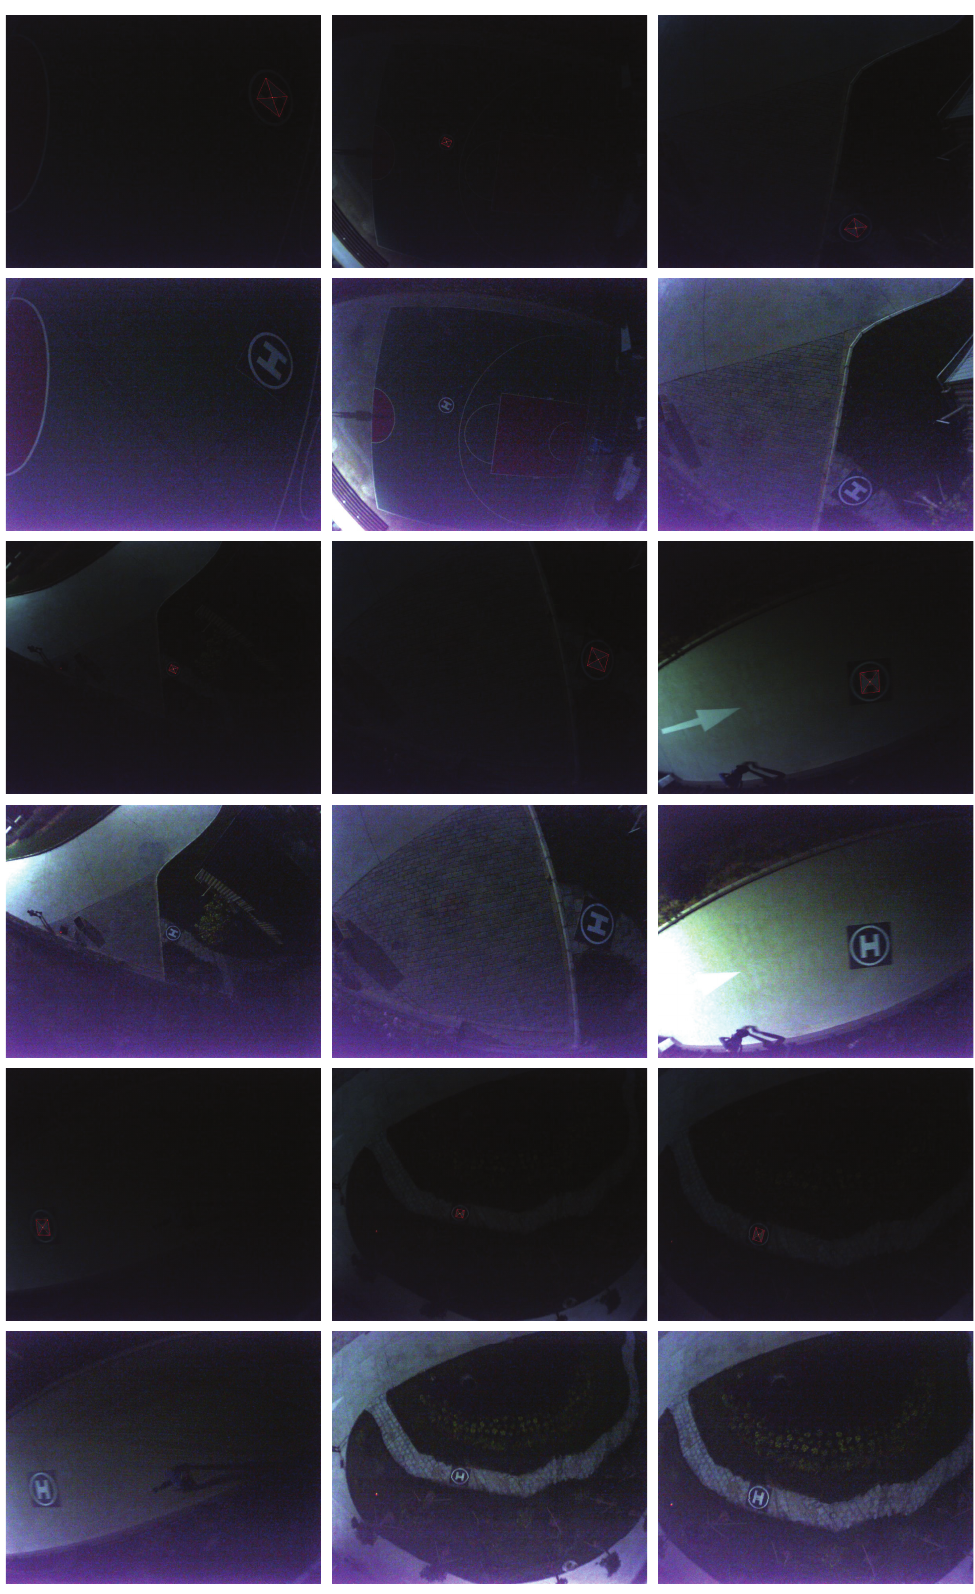
Figure 10. The landing marker detection results of the proposed vision system. The first, third, and fifth rows: Selected color images from the original test dataset. Detected markers are highlighted in color lines and dots. The second, fourth, and sixth rows: The corresponding color images after enhancement for scene detail